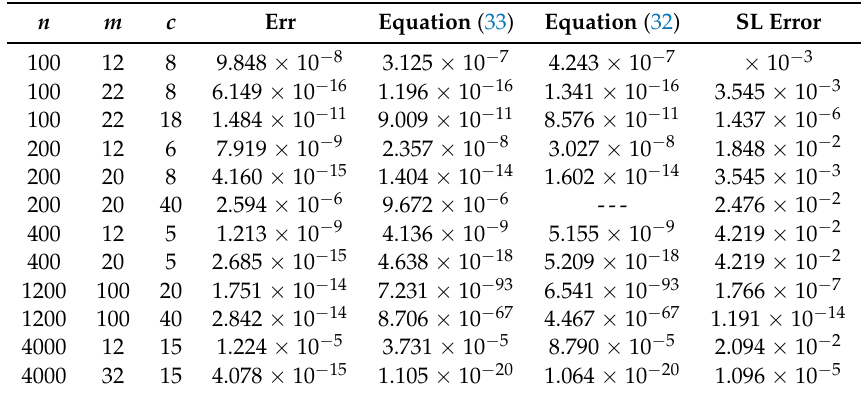
Table 3. Comparison of the error bounds of Equations (33) and (32) for imaginary time propagation. n is the size of the matrix; m is the size of the tridiagonal matrix; c is a parameter in A 2 ; and Err = | e − A 2 v − Qe − Λ Q T v |